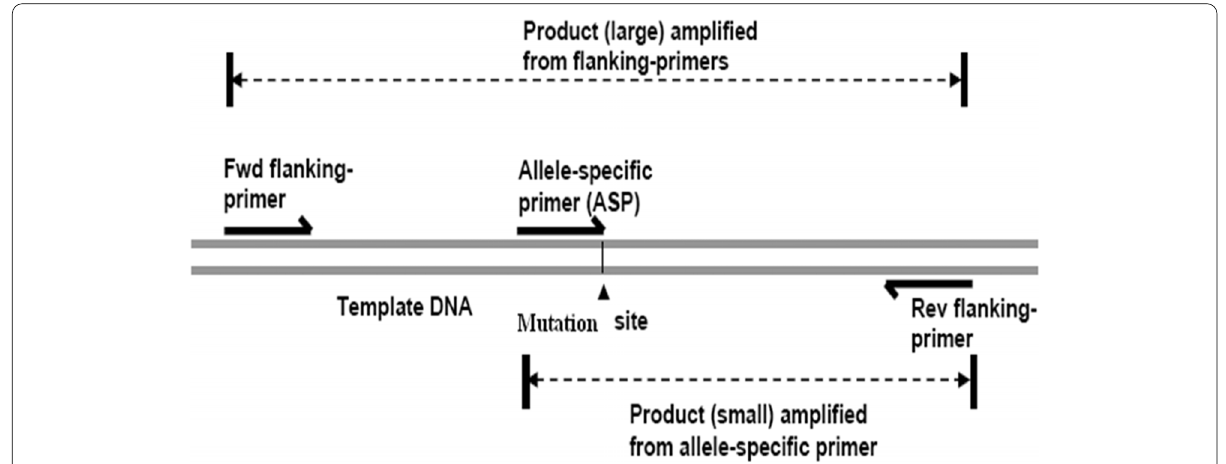
Fig. 1 Schematic representation of AS-PCR